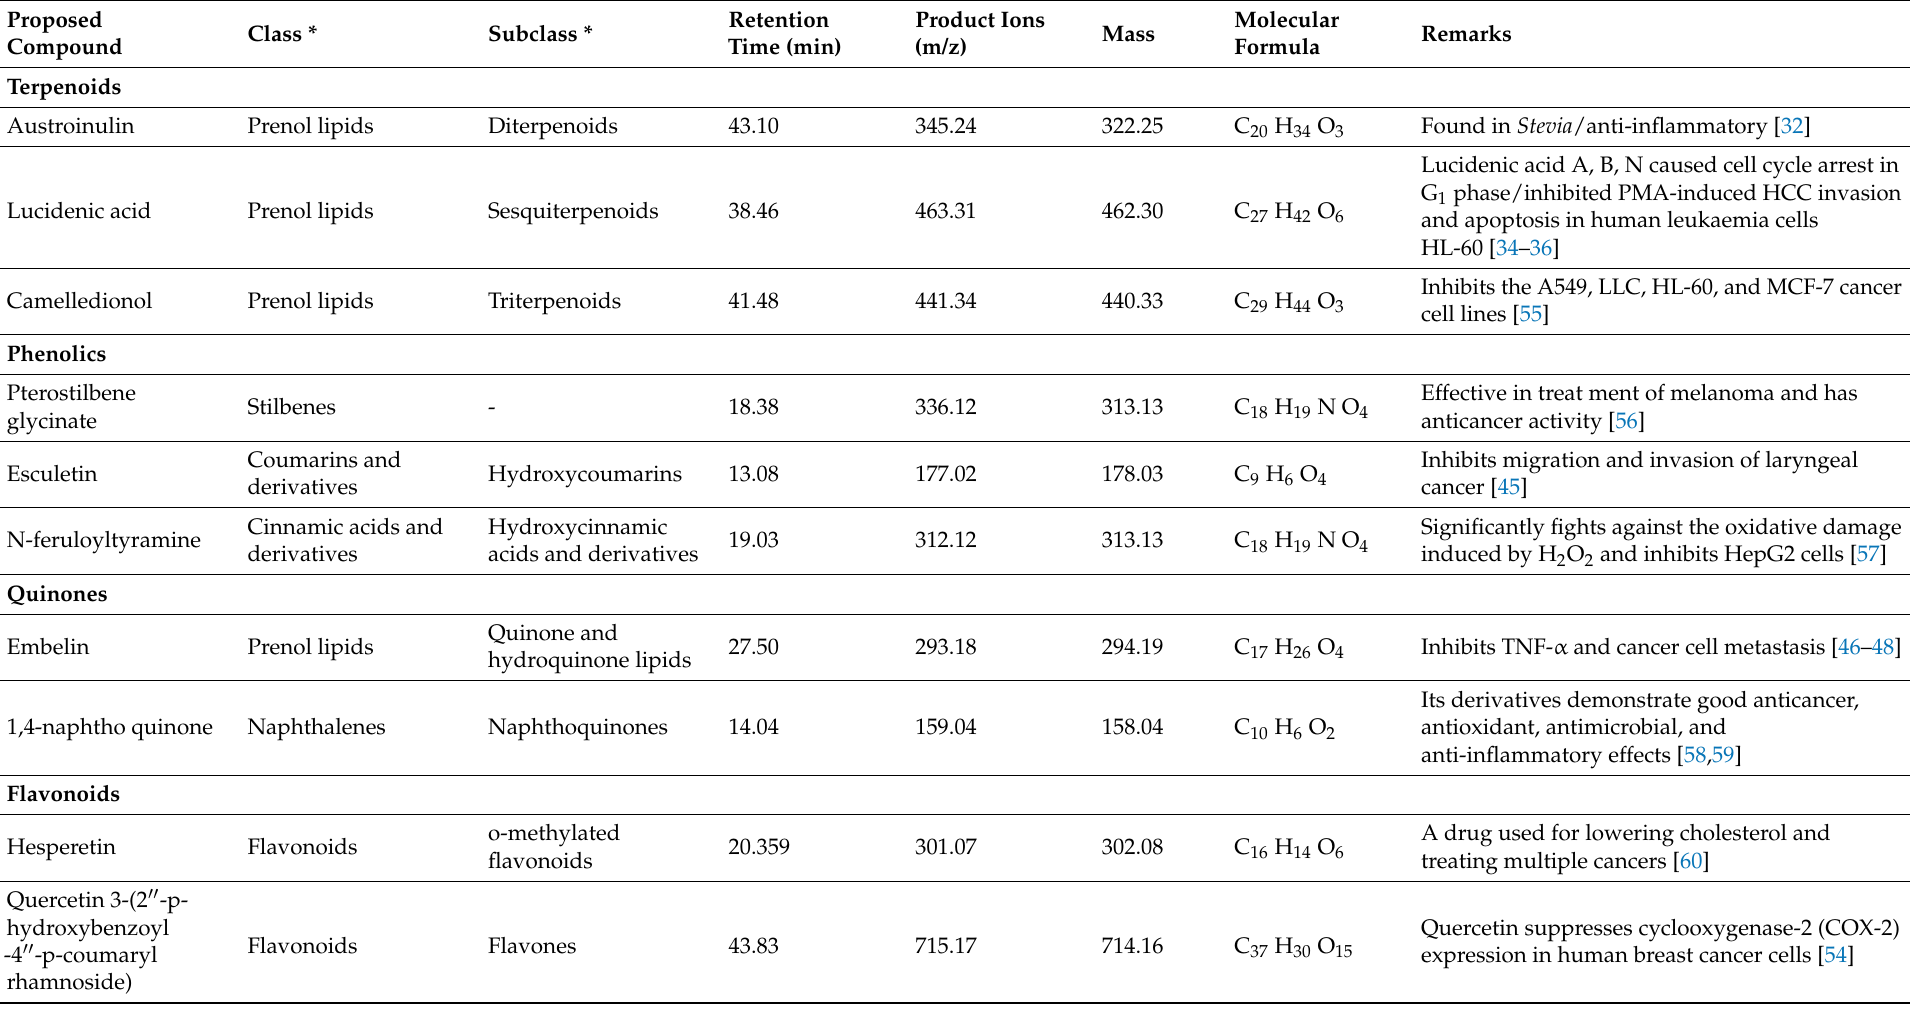
Table 3. A list of metabolites in R. nasutus SCC